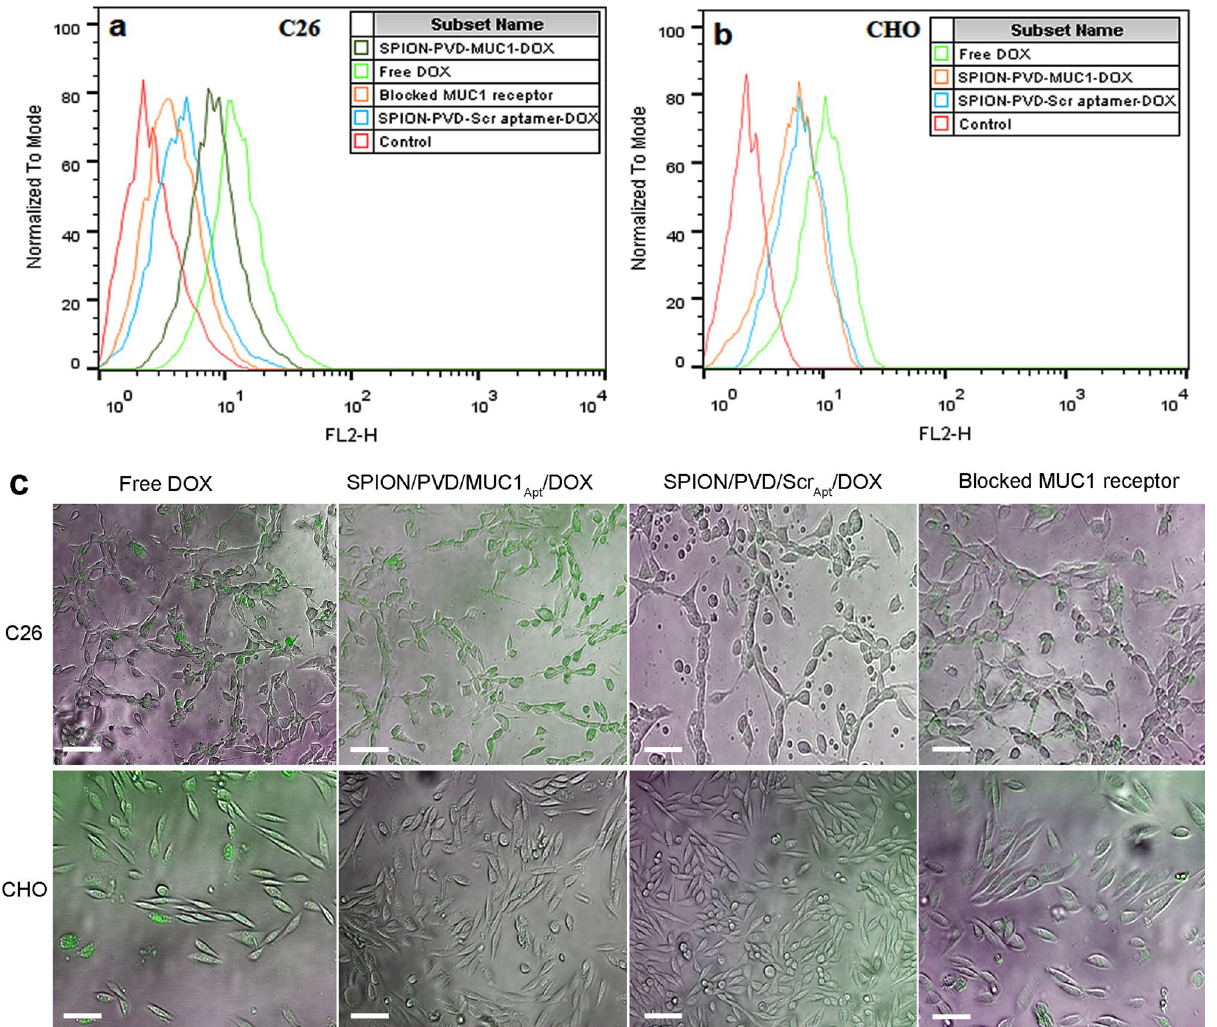
Figure 5. Quantitative and qualitative analysis of internalization of free DOX, SPION/PVD/MUC1 Apt /DOX and SPION/PVD/Scr Apt /DOX into C26 and CHO cell lines after 2.5 h of incubation using ( a , b ) flow cytometry and ( c ) fluorescence microscopy (the merged images of the DOX fluorescence channels and bright field; Scale- bar Lengths: 50